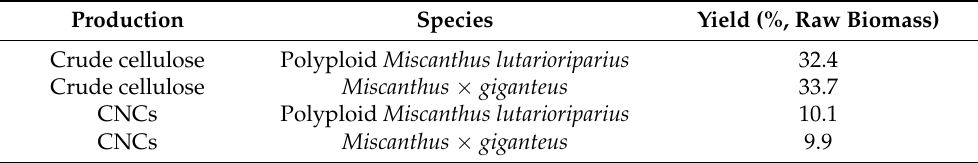
Table 3. Yield potential of crude cellulose and